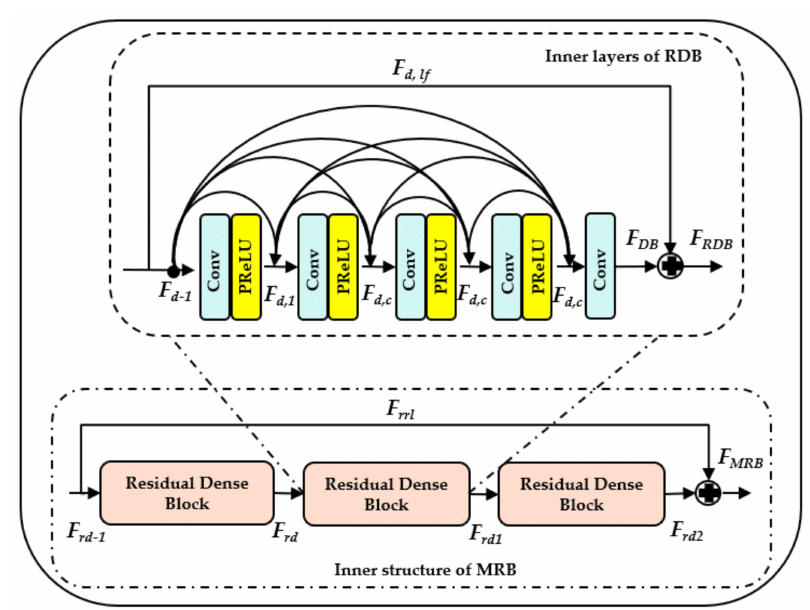
Figure 2. Structure of modified residual block for SR